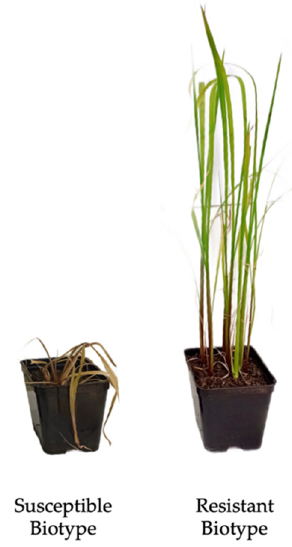
Figure 1. Echinochloa crus-galli susceptible and resistant biotypes observed three weeks after treatment with bispyribac-sodium. Wilting of the susceptible plant leaves is clearly visible.